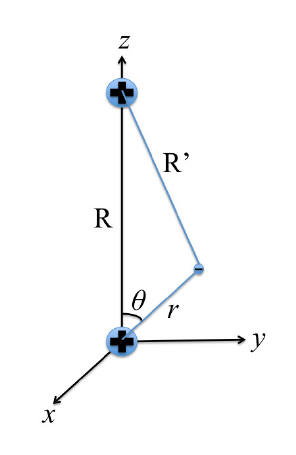
Figure 4. An ion at the top and an atom at the origin of the Cartesian coordinate are separated by a distance R.